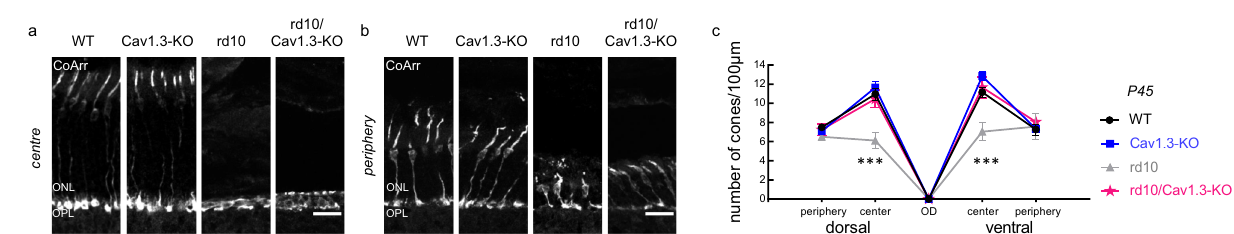
Figure 2. Number of cones in the central and peripheral regions at P45. Cones stained against cone arrestin in the central (a) and peripheral (b) retina of wild type, Cav1.3-KO, rd10 and rd10/Cav1.3-KO mice. ( c ) For spider plot analysis, the number of cones in 100 µm linear retinal length was counted in the center and periphery of dorsal or ventral retinas. Dorsal: centre: wild type (WT): 11 ± 0.6; Cav1.3-KO: 11.7 ± 0.7; rd10: 6.1 ± 0.9; rd10/ Cav1.3-KO: 10.5 ± 0.9; periphery: wild type: 7.5 ± 0.3; Cav1.3-KO: 7.1 ± 0.2; rd10: 6.5 ± 0.4; rd10/Cav1.3-KO: 7.2 ± 0.6. Ventral: centre: wild type (WT): 11.2 ± 0.5; Cav1.3-KO: 12.8 ± 0.5; rd10: 7 ± 0.9; rd10/Cav1.3-KO: 11.7 ± 1.1; periphery: wild type: 7.3 ± 0.6; Cav1.3-KO: 7.3 ± 0.3; rd10: 7.6 ± 1.3; rd10/Cav1.3-KO: 8 ± 0.5. N = 3 for all strains. Statistics: *** p < 0.001. Two-way ANOVA with Tukey multiple comparison test. Only the comparison between rd10 and rd10/Cav1.3-KO is indicated in the figure. There was no significant difference between wild type and Cav1.3-KO and rd10/Cav1.3-KO. Data are presented as means ± SEM. Scale bars: 20